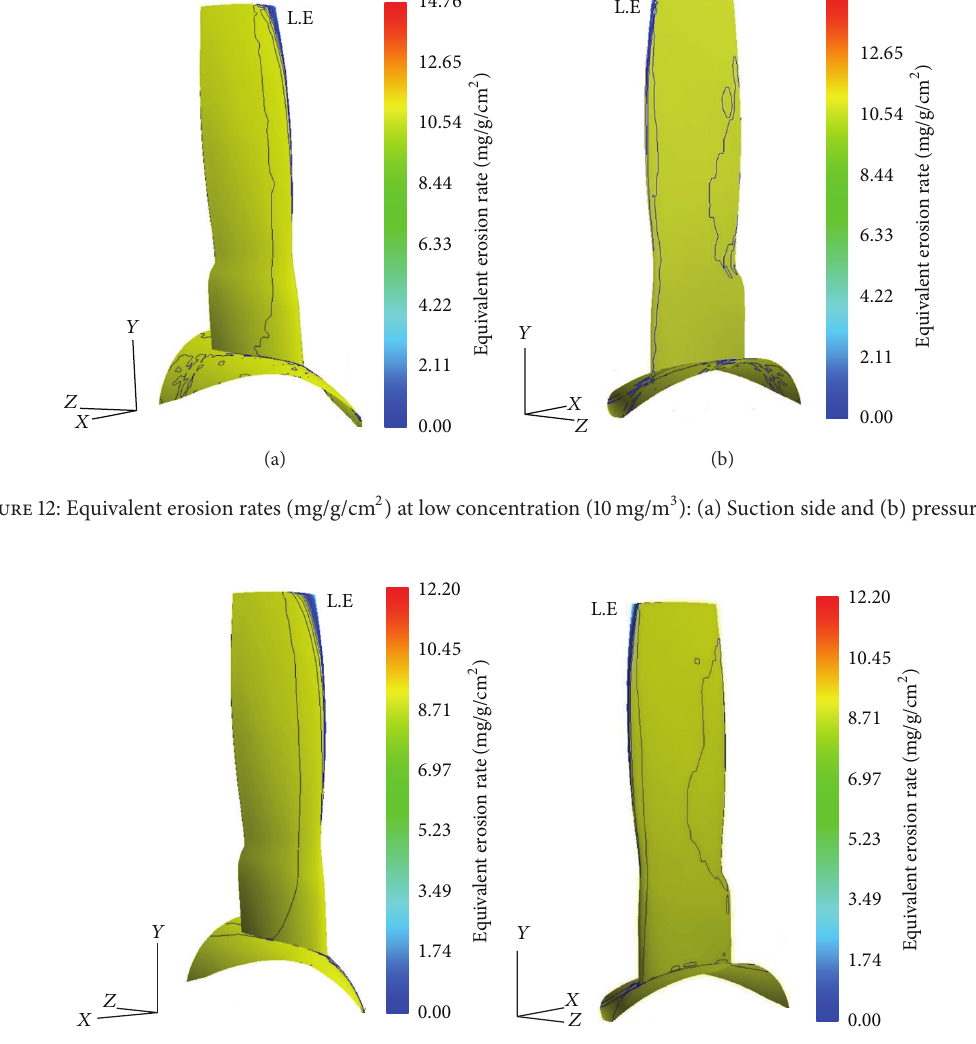
a distortion (blunt) of leading edge, which are generally the main sources in the aerodynamic performance